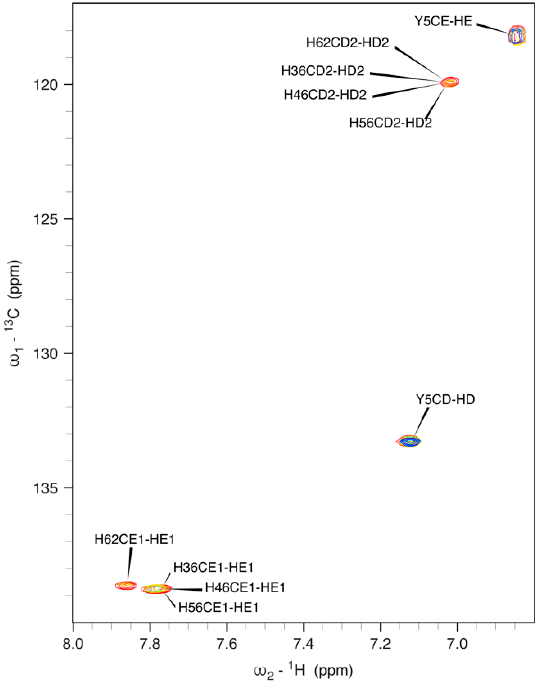
Figure 7. A 700 MHz (16.4 T) 1 H, 13 C HSQC spectrum of h NDRG1*C in the aromatic region, high- lighting the signals for the side-chain imidazole rings of His345, His355, His365 and His371, as well as Tyr314, at pH 7.5, as a function of incremental addition of Ni(II) (red: 0 eq; orange: 1 eq; cyan: 2 eq; blue: 3 eq).